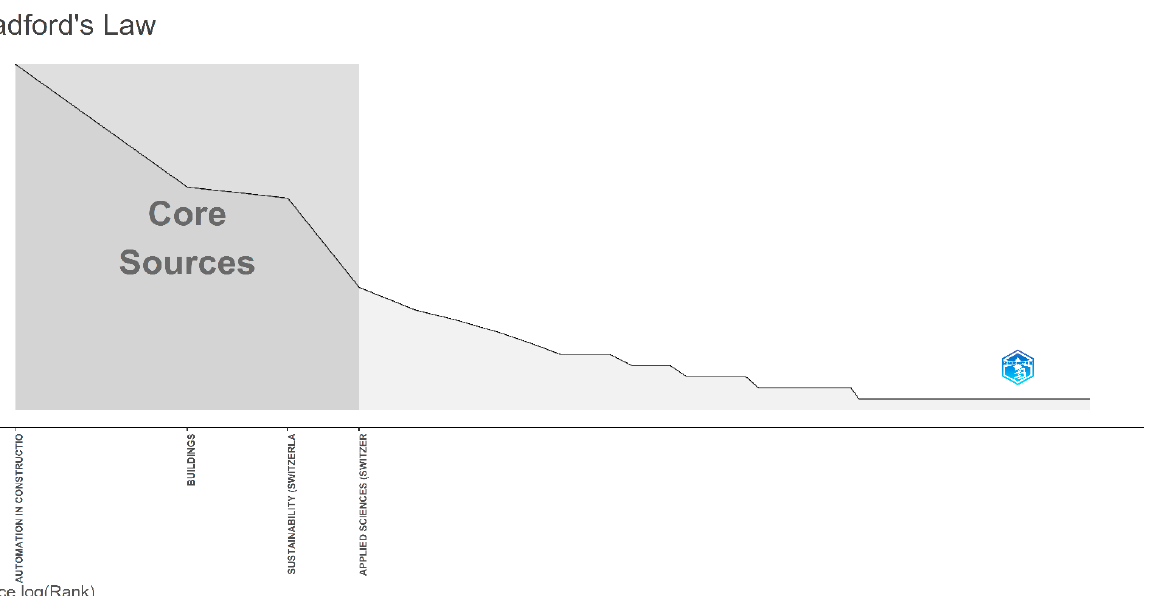
Figure 9. Sources’ articles publication by year analysis, performed with Biblioshiny version 4.0.